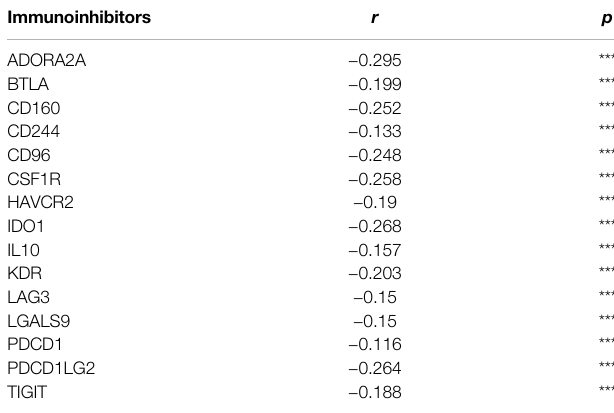
TABLE 2 | The correlation analysis between RETSAT and the expression of immunostimulators in SKCM validated by TIMER database. Immunostimulators r p